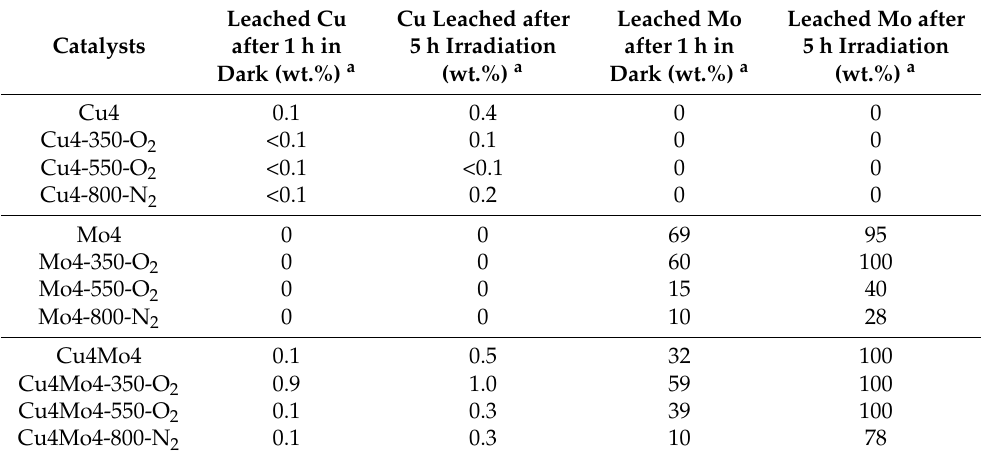
Table 7. Summary of the kinetics results of Cu and Mo detected in dark and irradiation conditions relative to nominal contents of elements listed in Table